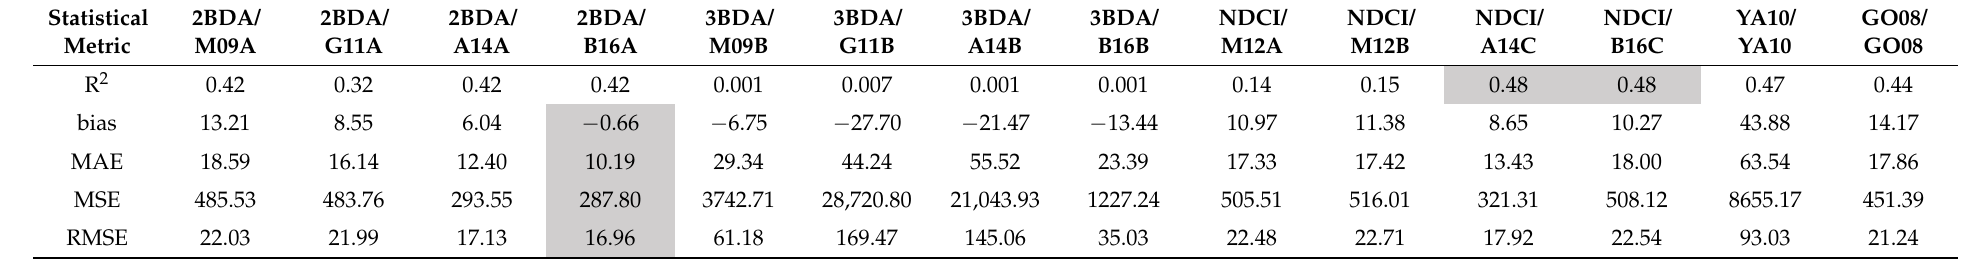
Table A1. Statistical metrics (R 2 , bias, MAE, MSE, RMSE) for different chl- a bio-optical algorithms from proximal hyperspectral in situ data from all lakes. 2BDA with G10A calibration and 3BDA with G10B calibration did not produce results. Shaded cells indicate the best values of each metric. Statistical Metric